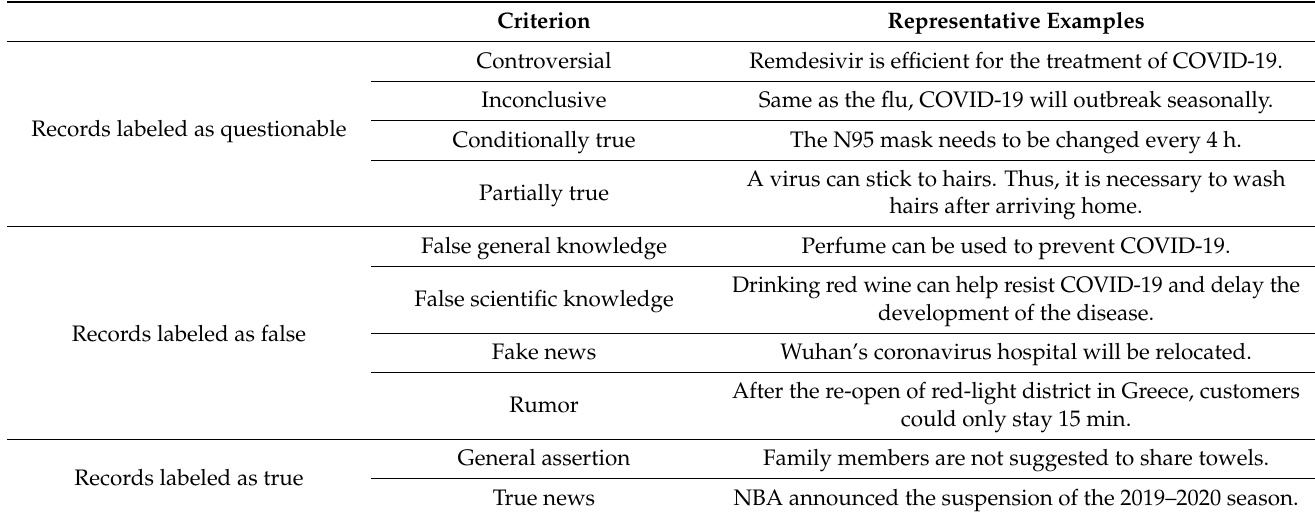
Table 1. Criterion and representative examples for records labeled as true, false or questionable in the WeChat mini-app “Jiaozhen”.